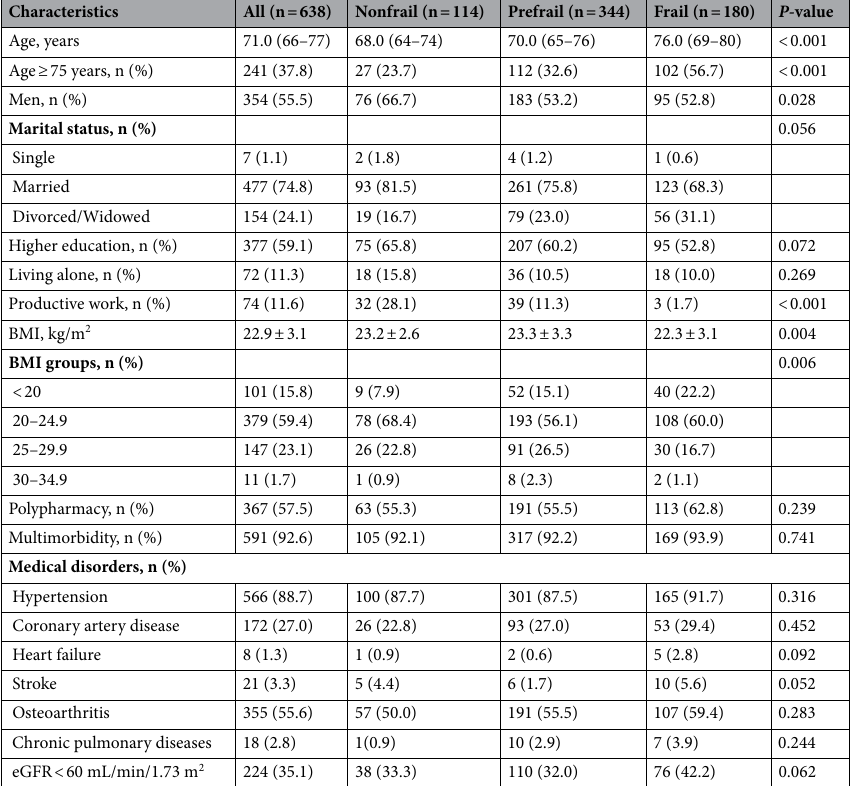
Table 2. Characteristics of the participants according to the Fried frailty phenotype. Categorical variables are described as frequencies (n) and percentages (%). Age is presented as median and interquartile range (25–75th percentile). BMI is described using means and standard deviations. Chi-square test or Fisher’s exact test was used to compare categorical variables. The one-way ANOVA was used to compare three means of BMI. The Kruskal–Wallis test was used to compare three medians of age. eGFR estimated glomerular filtration rate, BMI body mass index.